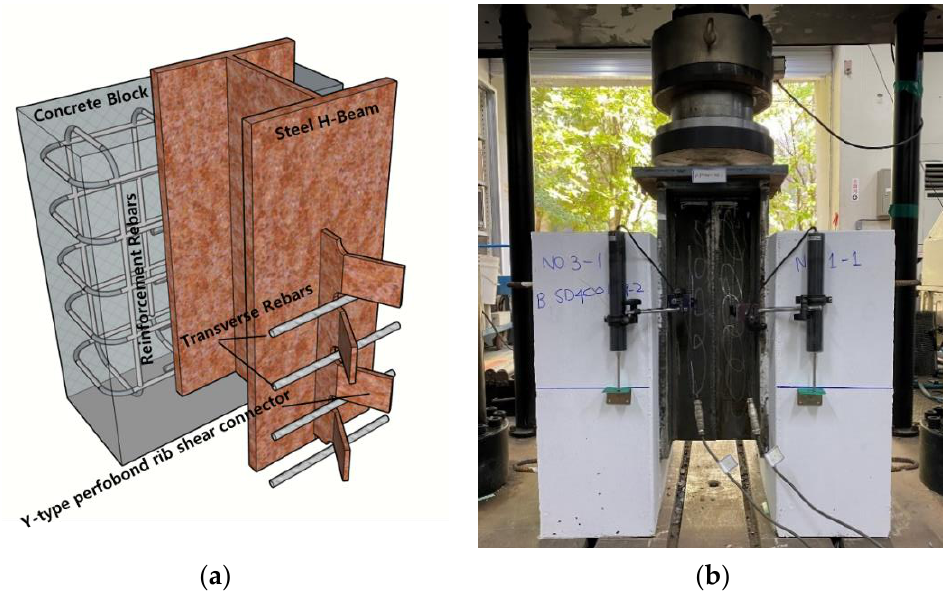
Figure 2. Test set-up: ( a ) Concept of test specimen with the Y-type perfobond rib shear connector (4 ribs). ( b ) Actual test set-up.